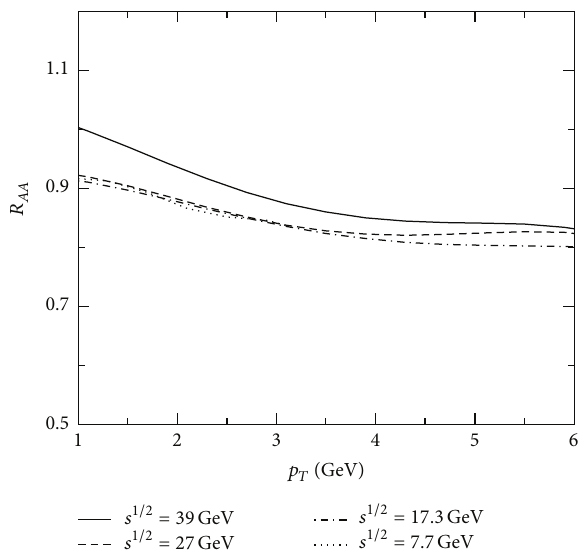
Figure 18: Nuclear suppression factor, 𝑅 𝐴𝐴 , as function of 𝑝 𝑇 for various √𝑠 𝑁𝑁 .